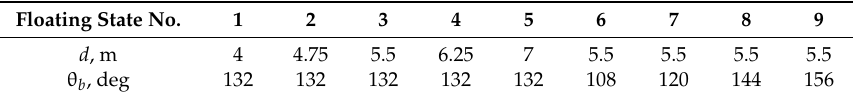
Table 1. Value of characteristic parameters of the floating